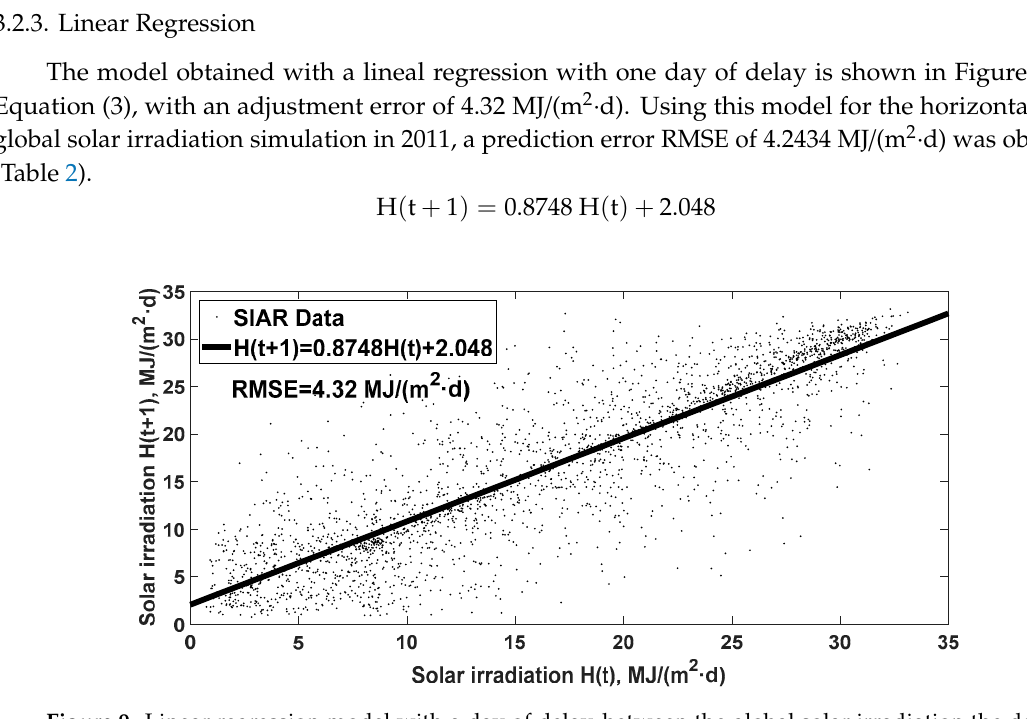
Figure 9. Linear regression model with a day of delay, between the global solar irradiation the day after [H(t+1), MJ/(m 2 ·d)] and the global solar irradiation of the current day [H(t), MJ/(m 2 ·d)]. Data from the agrometeorological station SIAR located in Mansilla Mayor, León, Spain, for a seven years series. RMSE, root mean square error (MJ/(m 2 ·d)).